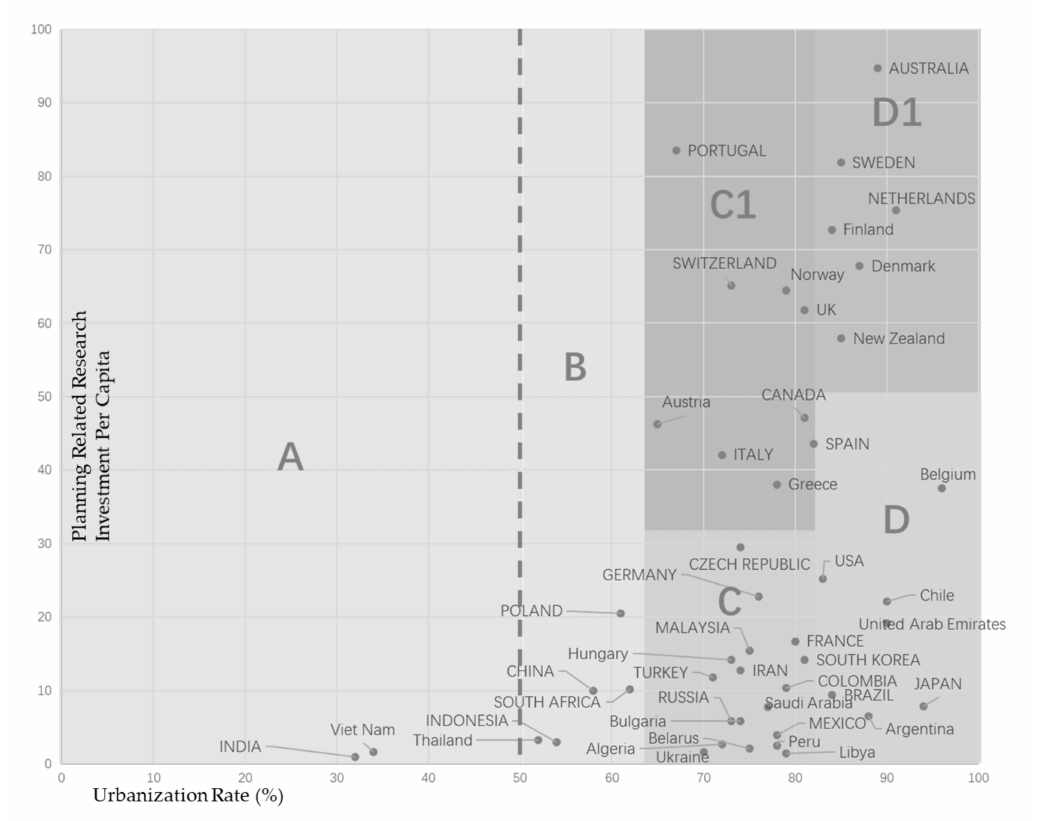
Figure 3. Dynamic relationship between investment in planning research and urbanization [30]. Source: based on data from Web of